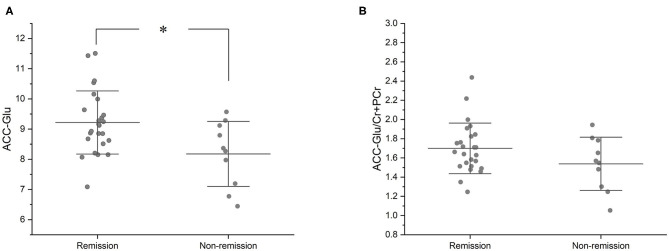
Baseline Glu and Glu/Cr+PCr in ACC of remission and non-remission groups. (A) At baseline, the remission group had a significantly higher Glu level than the non-remission group (mean values, 9.22 ± 1.05 vs. 8.17 ± 1.08; T33 = −2.634, P = 0.013). (B) At baseline, the remission group had a higher Glu/Cr+PCr than the non-remission group, but there was no statistically significant difference between the two groups (mean values, 1.67 ± 0.26 vs. 1.53 ± 0.28; T33 = −1.612, p = 0.117). *p < 0.05.